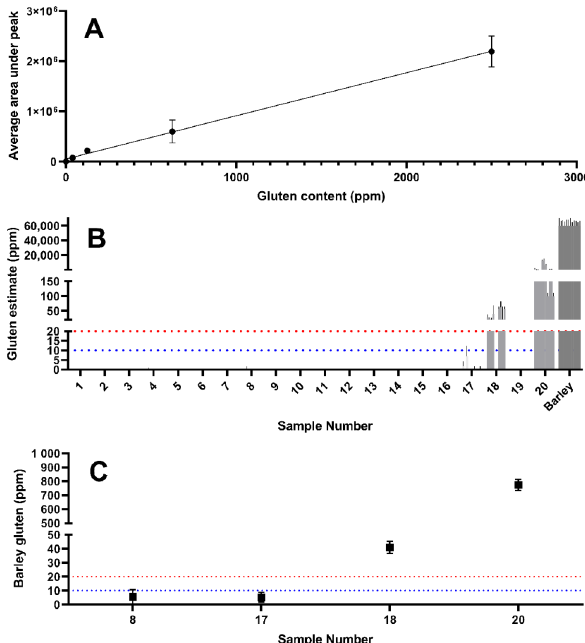
Figure 8. ( A ) Standard curve of barley gluten in yeast extract. Barley-derived gluten was spiked into gluten-free yeast extract at known concentration. ( B ) Estimates of barley-derived gluten concentration in samples 8, 17, 18, and 20 ( n = 4 replicates). ( C ) Barley gluten estimate based on the sample mean of all barley gluten peptides and interpolated from the calibration curve. The dashed red line represents the 20 mg / kg threshold, whilst the dashed blue line represents the 10 mg / kg GFCO certification